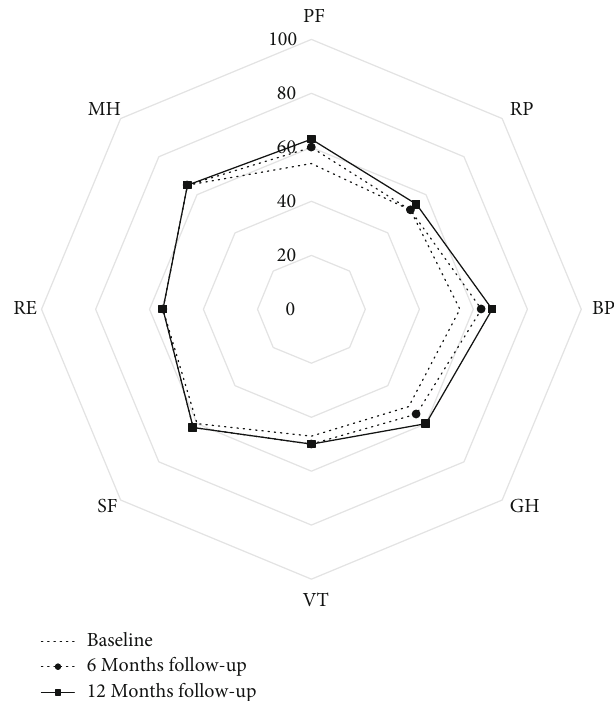
Figure 3: Short Form Health Survey (SF-36) results at baseline, 6 months, and 12 months after ADSC implantation. PF: physical functioning; RP: role-physical; BP: bodily pain; GH: general health; VT: vitality; SF: social functioning; RP: role-emotional; MH: mental